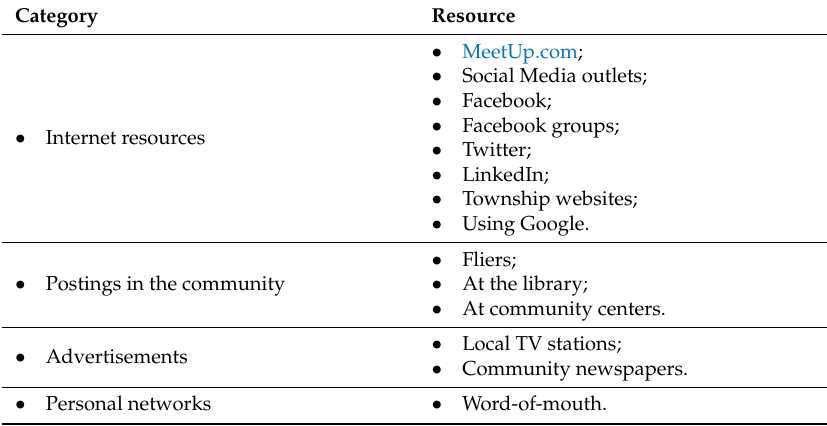
Table 3. How participants access information about local outdoor green